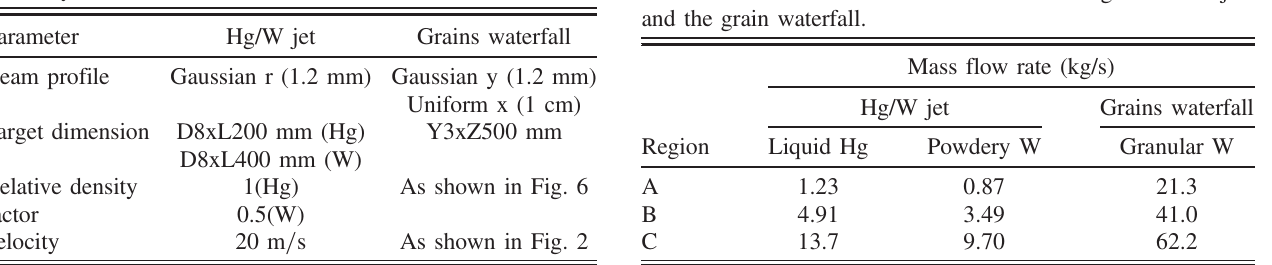
TABLE I. Parameters of the beam profile and the target geometry.